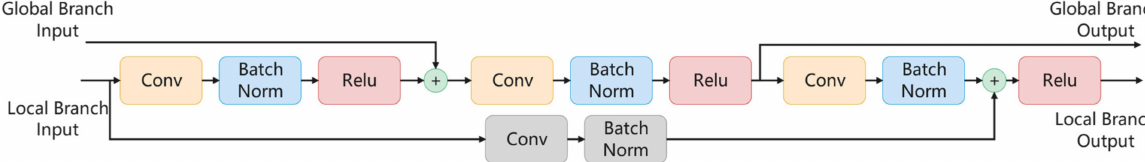
Figure 5. Preprocessing module.